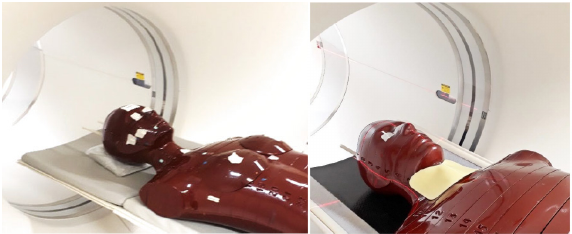
Figure 1. Positioning of the Male and Female Alderson Phantom Without (Female) and With (Male) the Bismuth Shielding on the Thyroid Gland. Note . Copyright permission was obtained from the author and the editor for using these images.